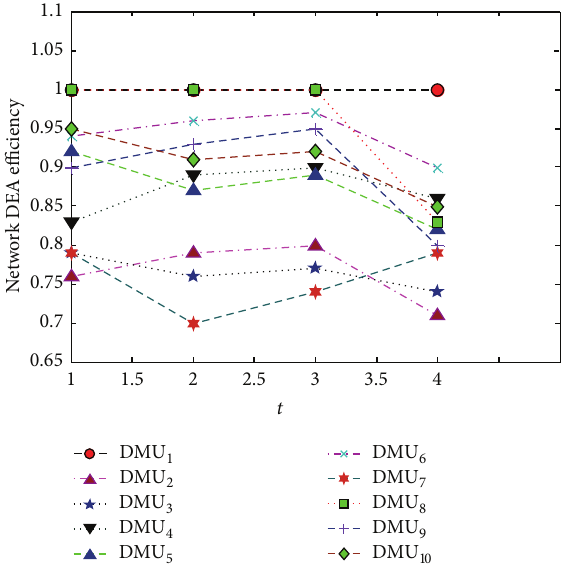
Figure 7: Dynamic fluctuation of network DEA efficiency.